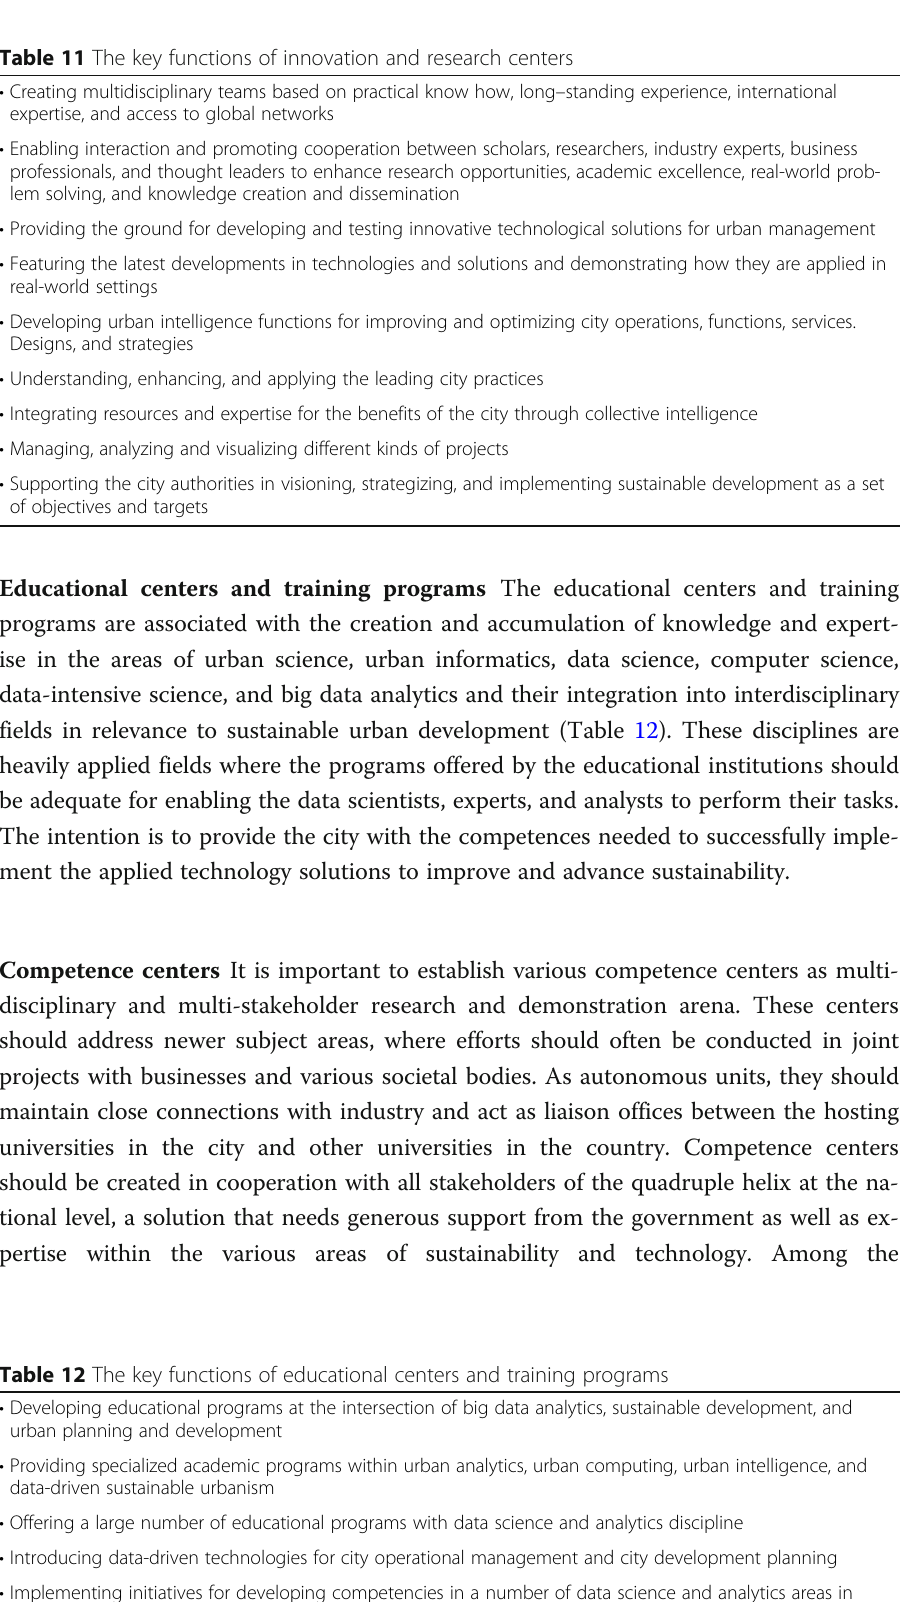
Table 12 The key functions of educational centers and training programs (cid:129) Developing educational programs at the intersection of big data analytics, sustainable development, and urban planning and development (cid:129) Providing specialized academic programs within urban analytics, urban computing, urban intelligence, and data-driven sustainable urbanism (cid:129) Offering a large number of educational programs with data science and analytics discipline (cid:129) Introducing data-driven technologies for city operational management and city development planning (cid:129) Implementing initiatives for developing competencies in a number of data science and analytics areas in relation to urban sustainability by conducting seminars and providing trainings to improve the level of the applied technological knowledge in this